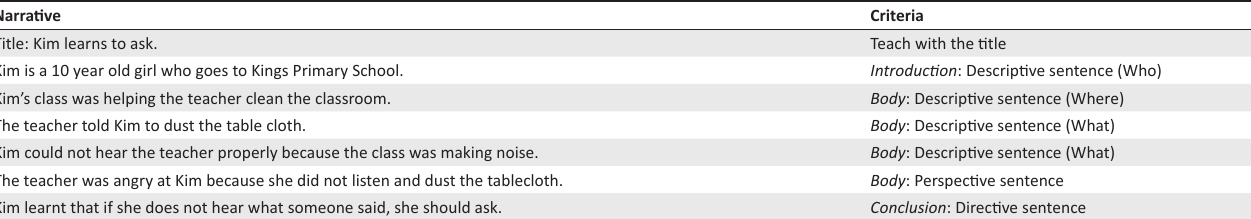
TABLE 2-A2: Example of narrative reflecting application of the principles of social